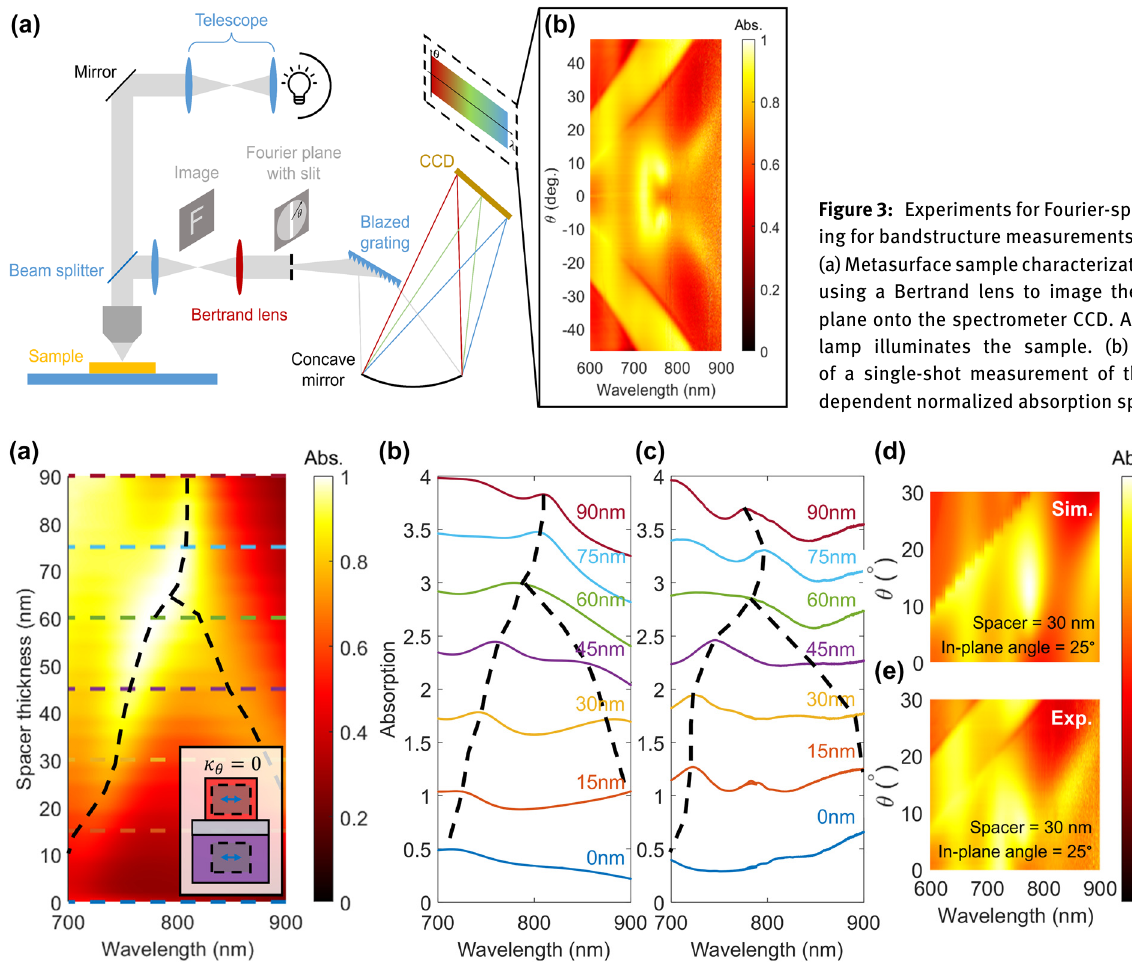
Figure 4: Experimental characterization of non-Hermitian metasurfaces (a) simulated device excited by a normally incident plane wave. Coupling between photonic and plasmonic horizontal modes is tuned by the silica spacer thickness, revealing a PT-phase transition and exceptional point for a 65 nm spacer. Inset: Schematic showing excited horizontal modes and no coupling to vertical modes. (b) Simulation and (c) experimental characterization of metasurfaces excited by normally incident light, confirming the presence of an exceptional point. (d) Simulation and (e) experimental characterization of angle-dependent absorption spectrum show qualitative agreement. Absorption for an in-plane angle of 25 ◦ in the PT-symmetric regime (spacer = 30 nm) is